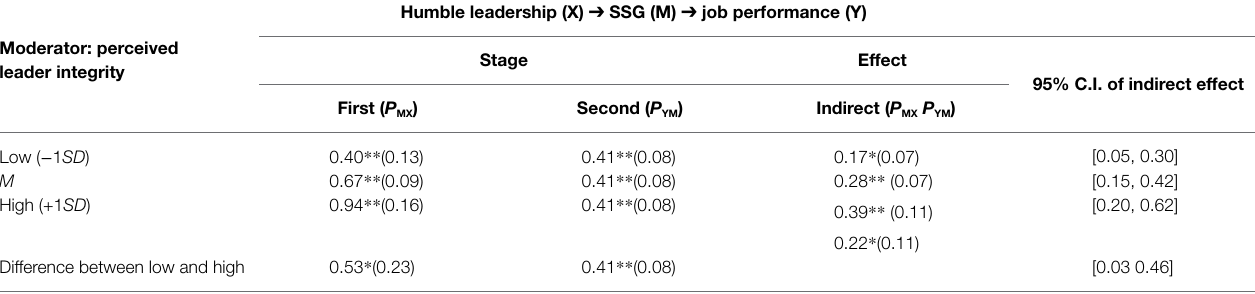
TABLE 4 | Conditional indirect effects of humble leadership on job performance via SSG.